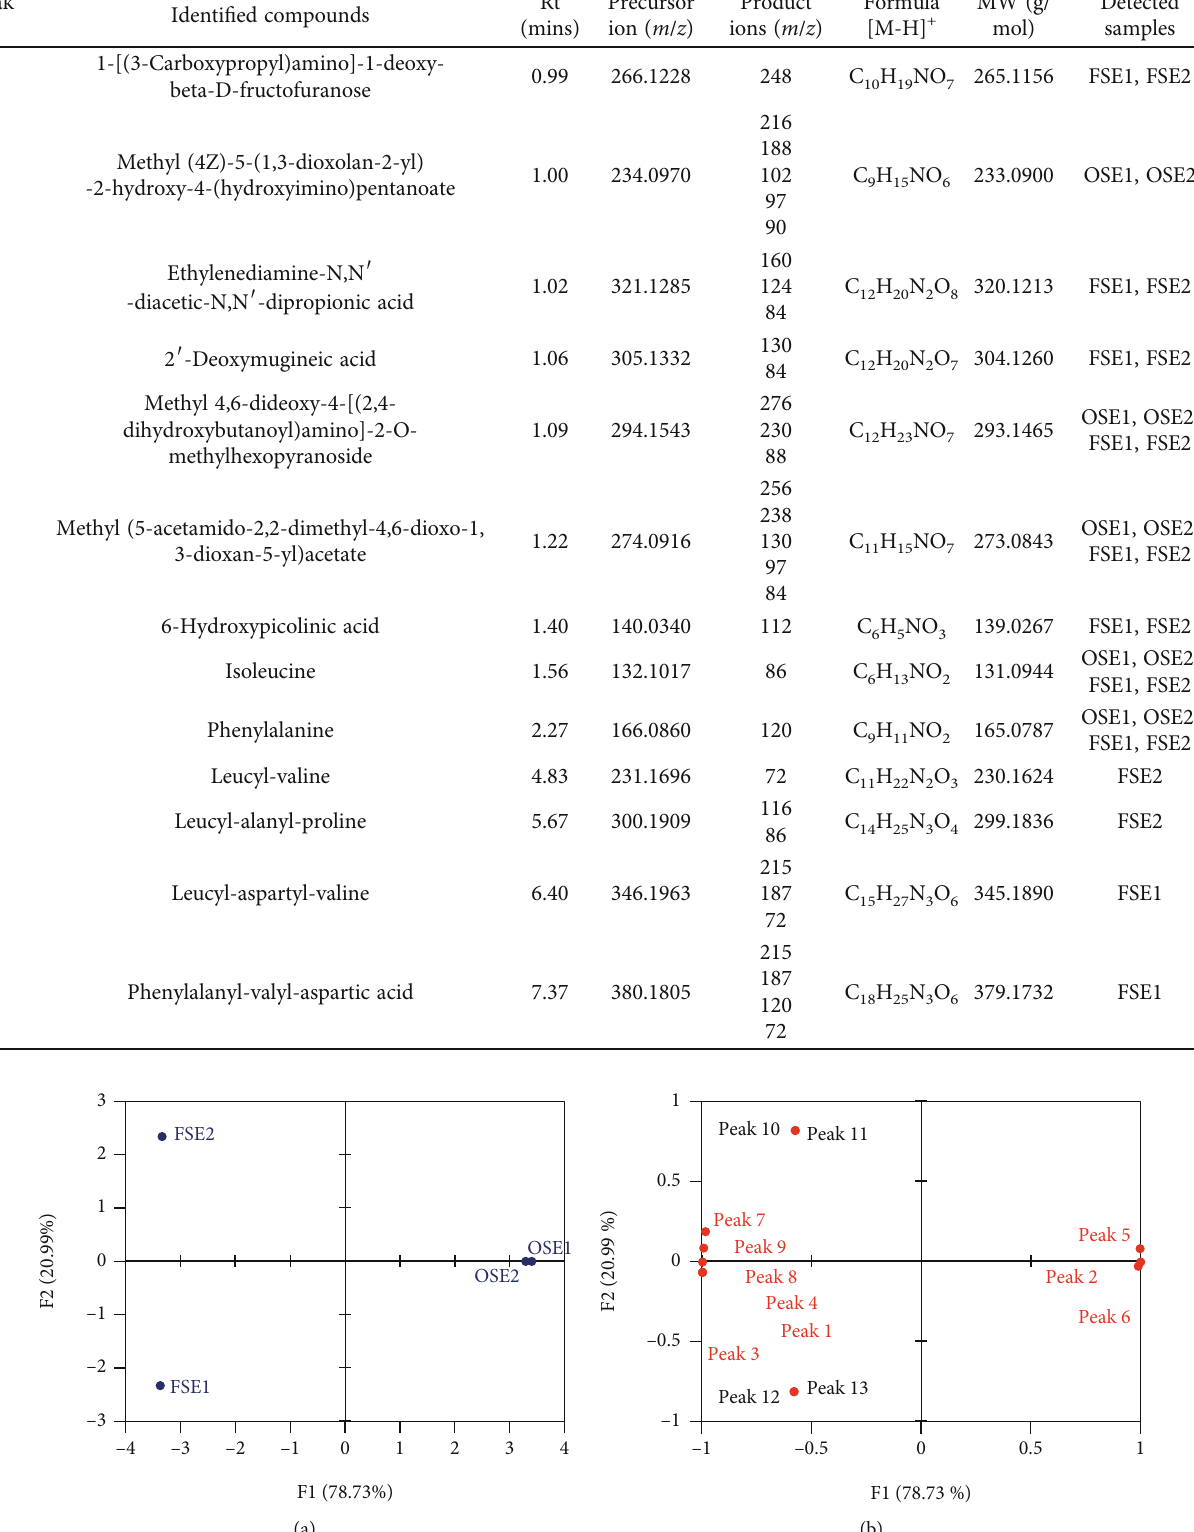
Figure 4: PCA results of the fraction < 3 kDa of water extract of old and fermented P. edule seeds: (a) score plot; (b) loading